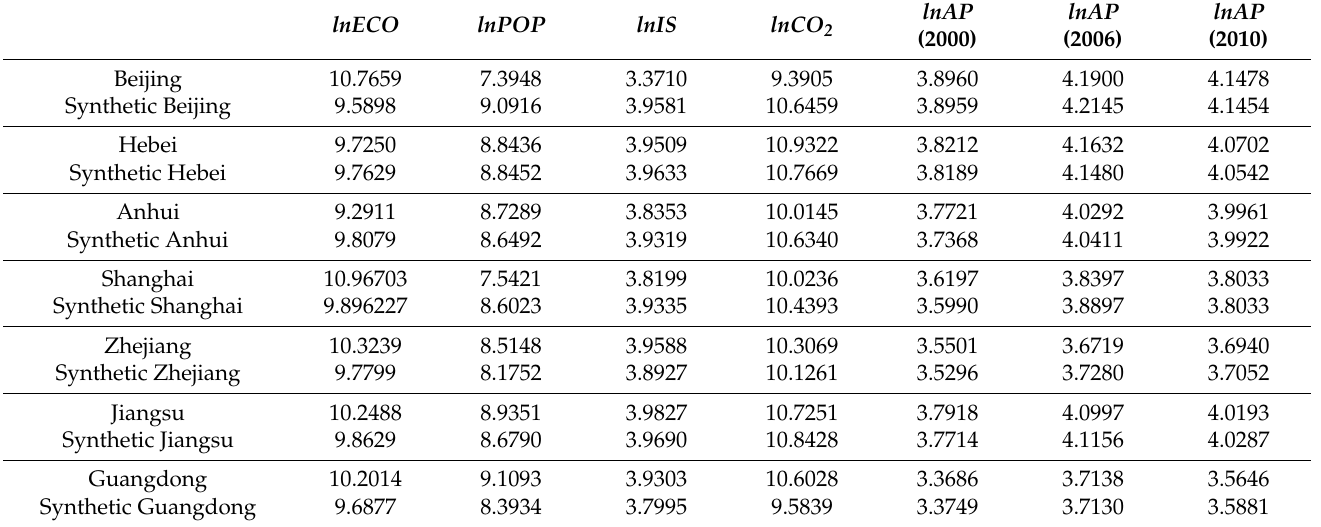
Table 4. Comparison of predictor variables.